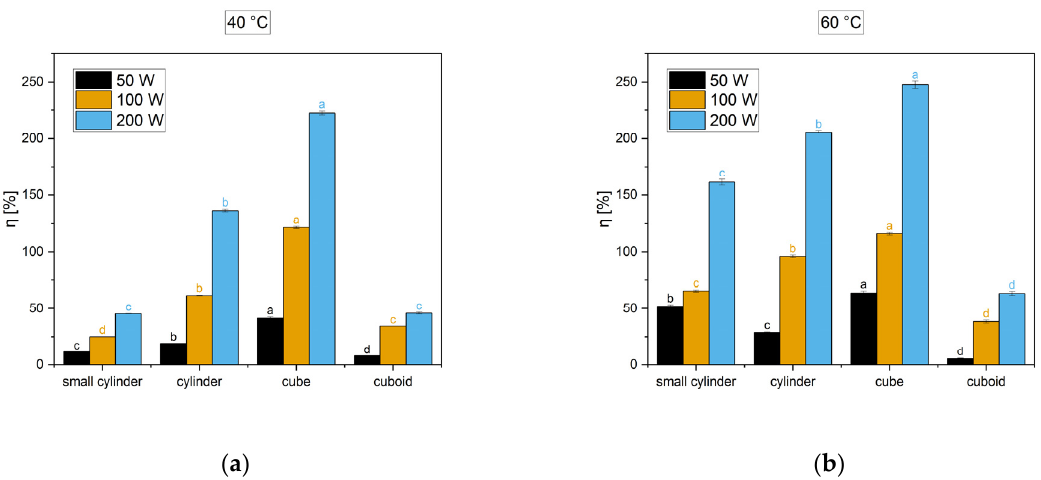
Figure 6. Heat transfer enhancement ratios η (%). Air temperature: ( a ) 40 °C; ( b ) 60 °C. Presented data are mean ± standard deviation. Different letters above the bar of the same color indicate statistically significant difference at p ≤ 0.05 in accordance to Tukey posthoc mean comparison.